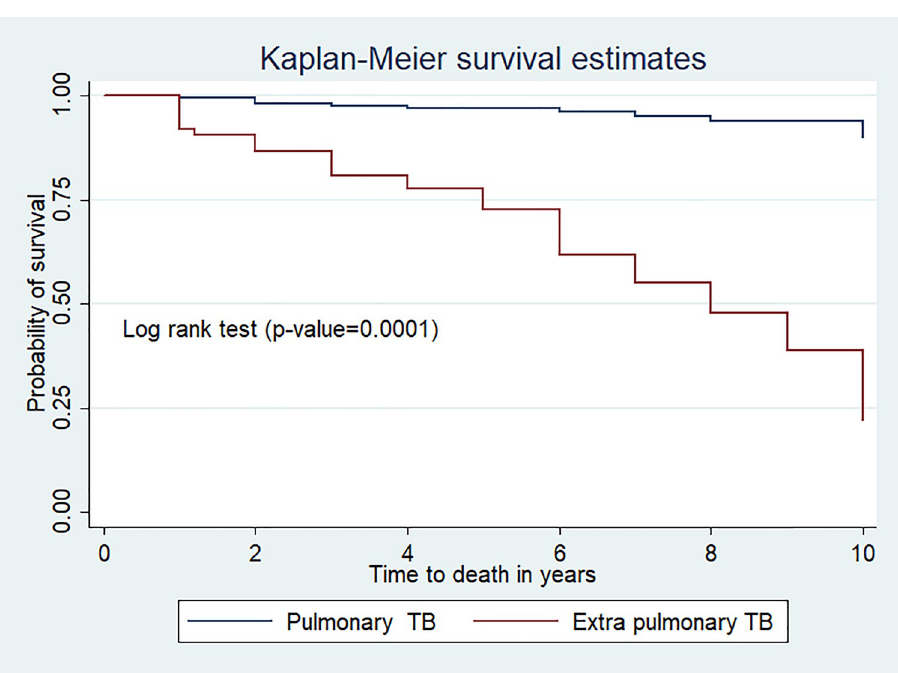
Fig 5. Kaplan Meier survival curve of infection among TB/HIV co-infected children at public hospitals, Southern Ethiopia.